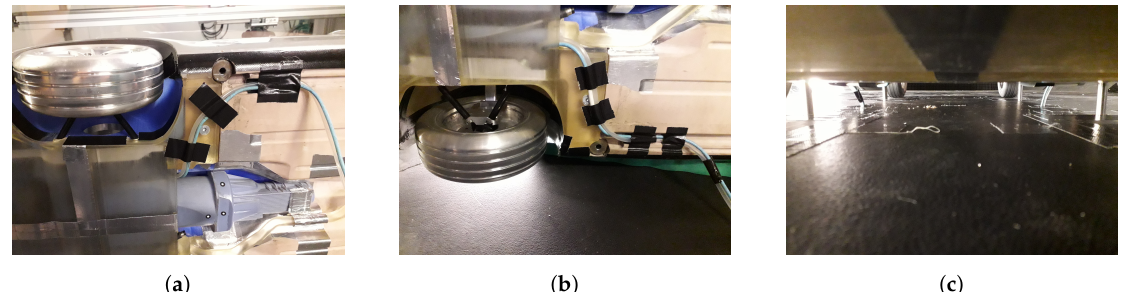
Figure 7. Images showing the pressure scanner cable routing. ( a ) Routing on the left hand side ( − Y ) of the model; ( b ) Routing on the right hand side ( + Y ) of the model; ( c ) Routing from both sides down and through the floor.